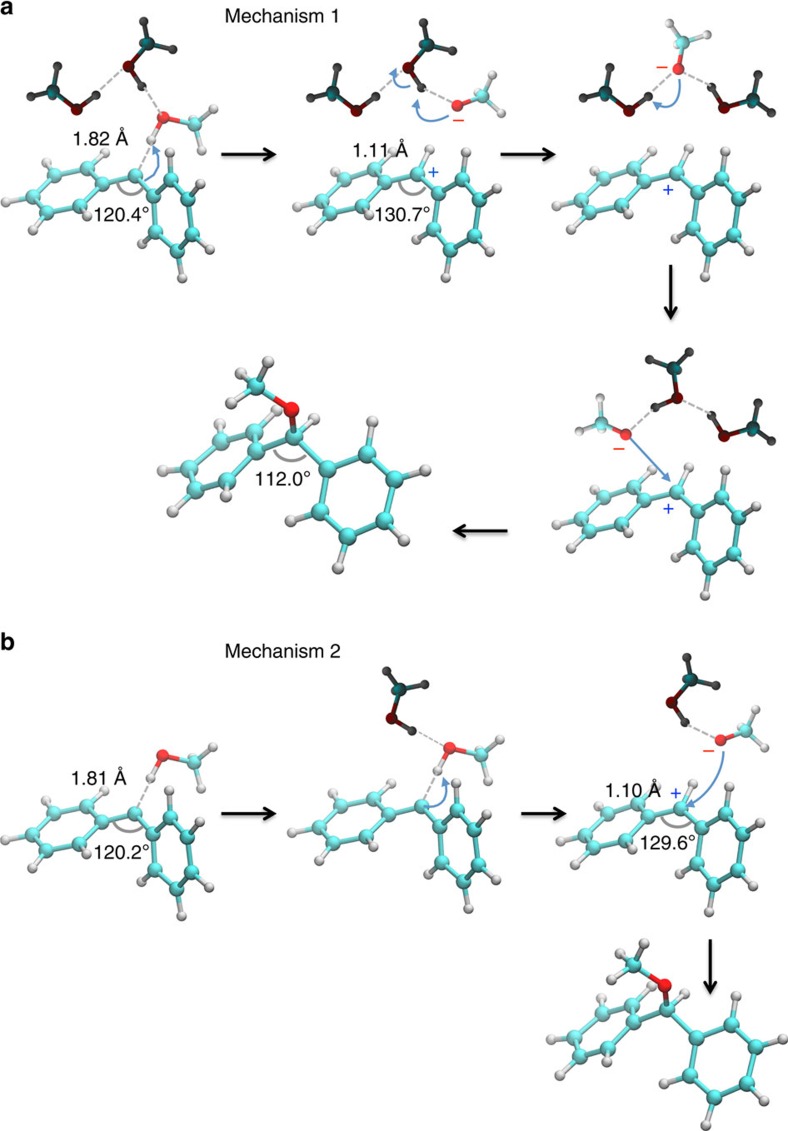
Mechanisms 1 and 2 of O–H insertion for the reaction of 1Ph2C with methanol.(a) Mechanism 1, (b) Mechanism 2. Average OḢ̇̇C1Ph2C distances and CCC1Ph2C angles are shown.